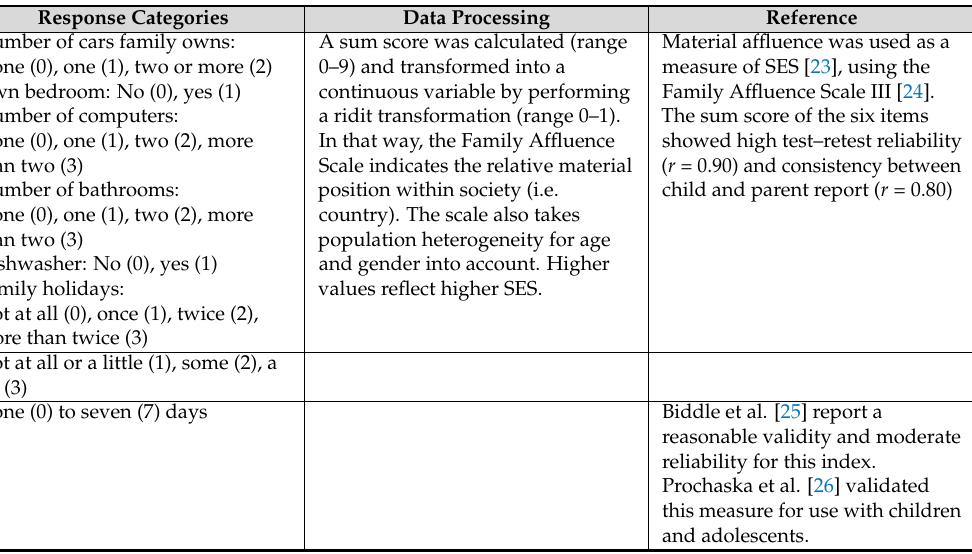
Table 1. Overview of used